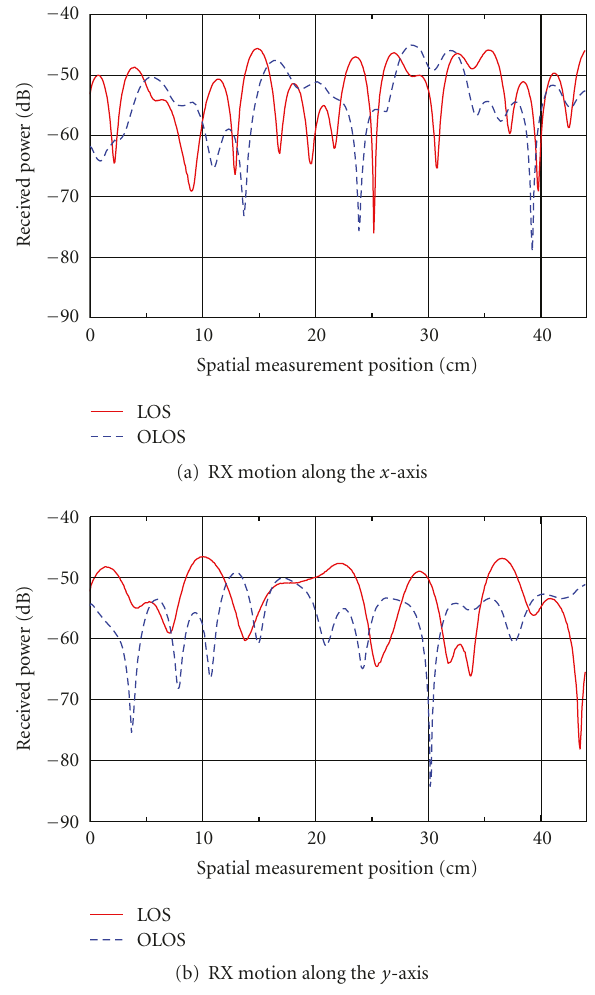
Figure 9: Received power of SISO channel in the spatial domain at the frequency of 5.15